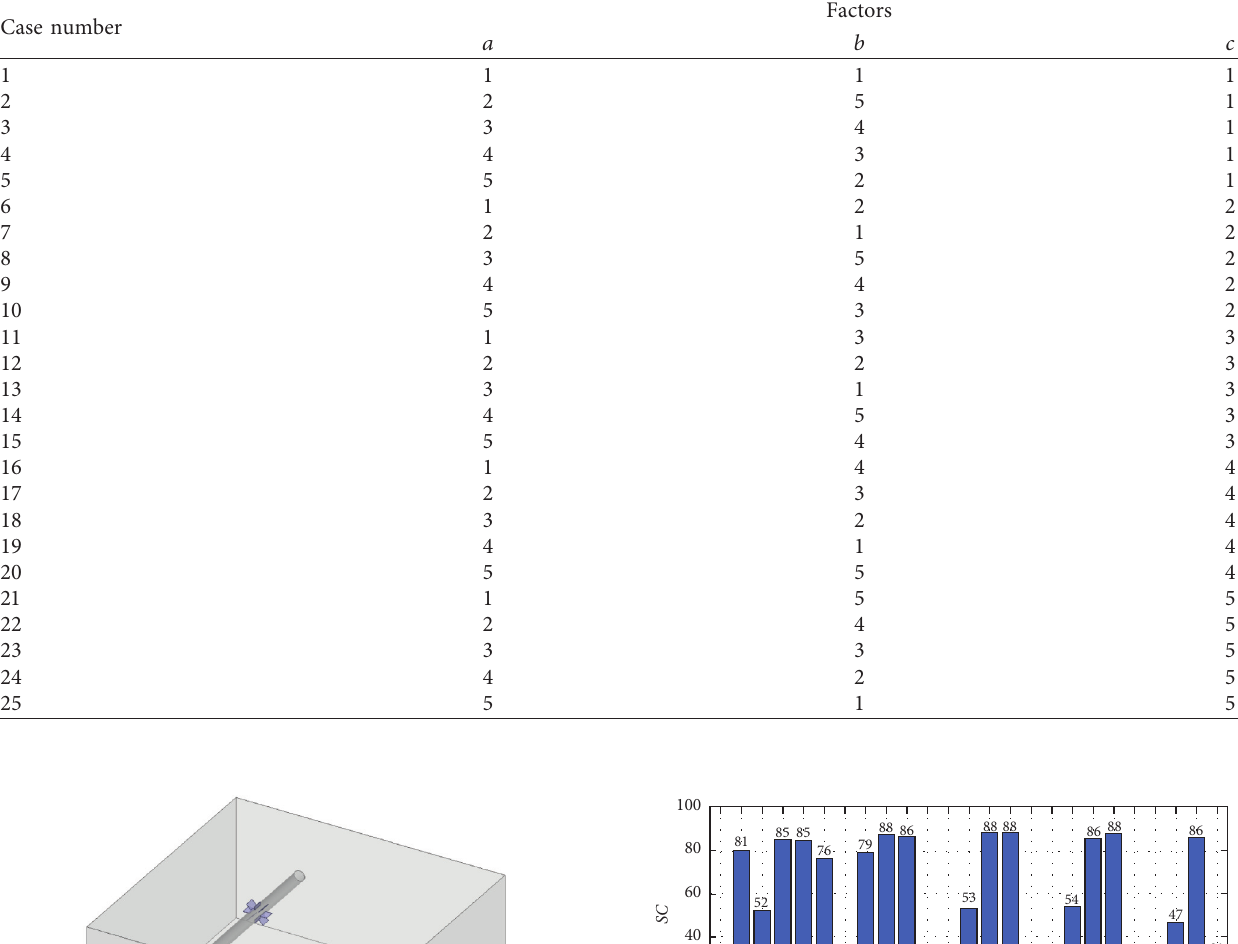
Table 3: Simulation scheme.